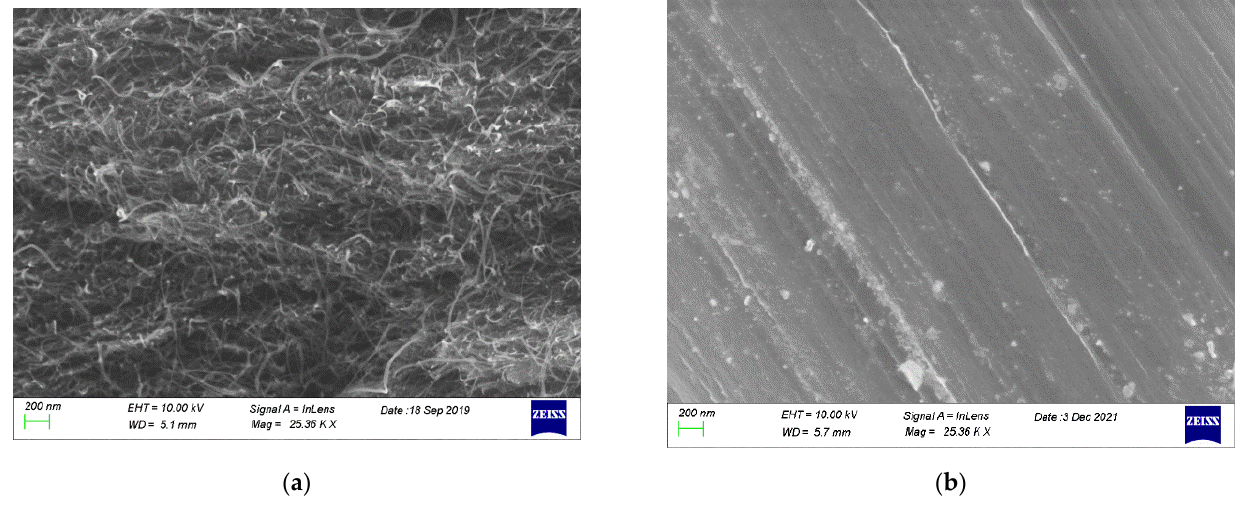
Figure 2. SEM image (top view) of ( a ) the prepared Thin-MWCNT-COOH buckypaper and ( b ) CP (for comparison).